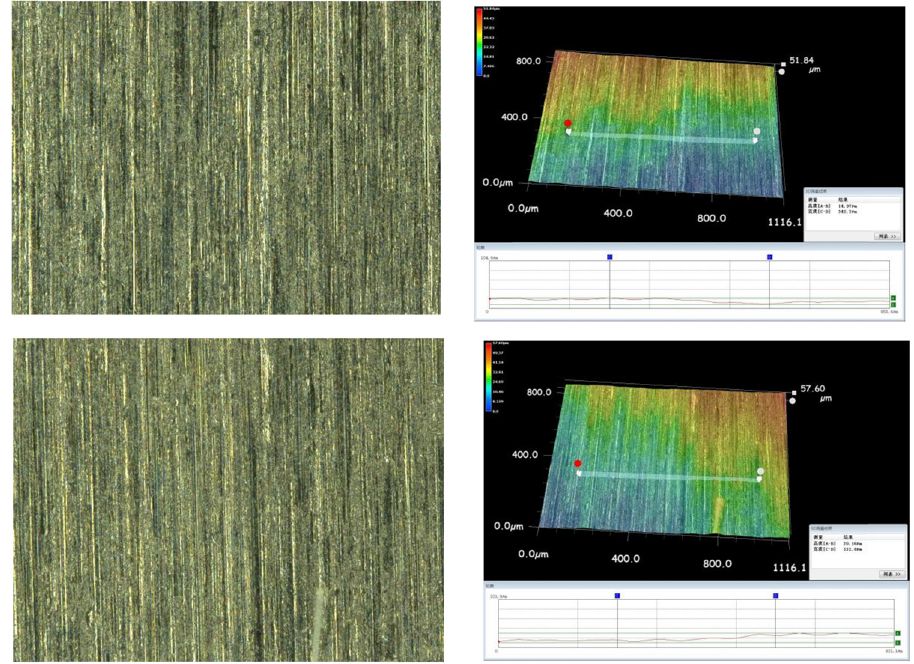
Figure 11: Grinding morphology of sample after grinding wheel